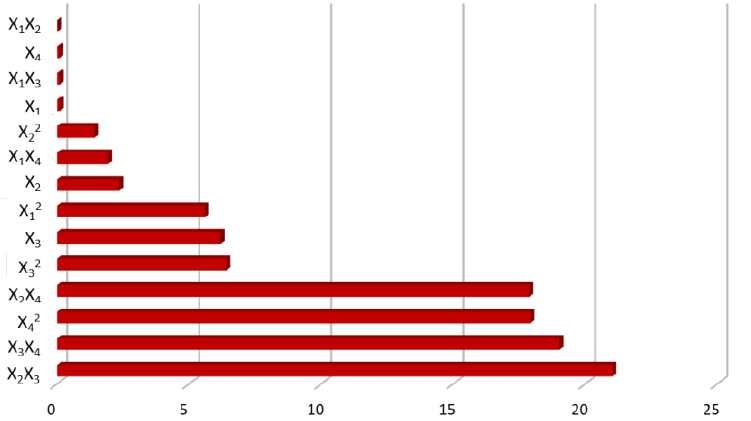
Figure 2. Detailed diagram of the percentage contribution of the linear, the two-factor interaction and the quadratic effects on the total phenolic content of olive mill pomace